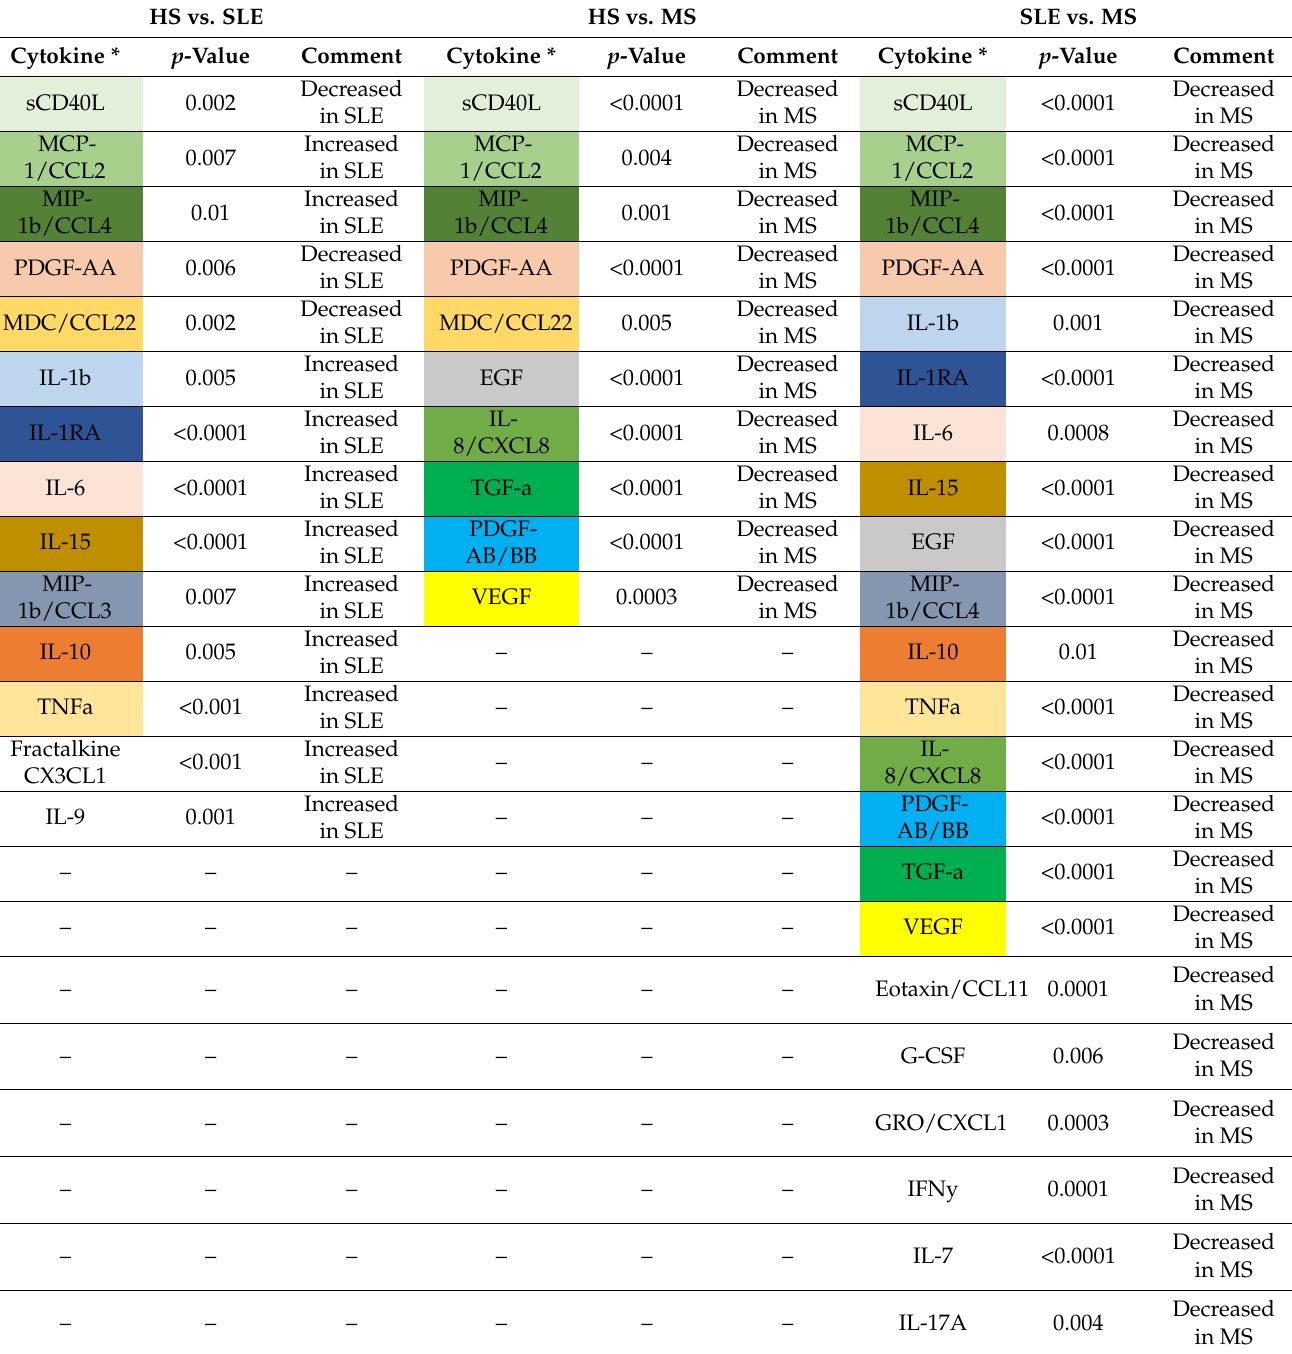
Table 2. Summary of cytokines whose serum levels changed significantly in the analyzed